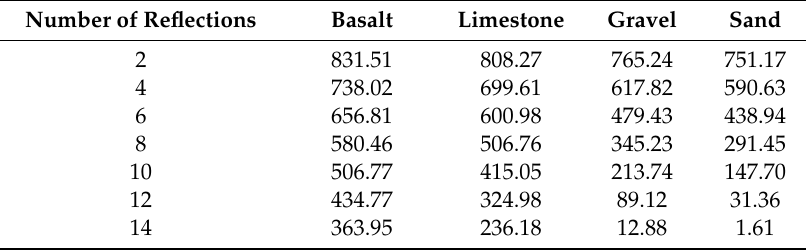
Table 5. Results of capacity for di ff erent